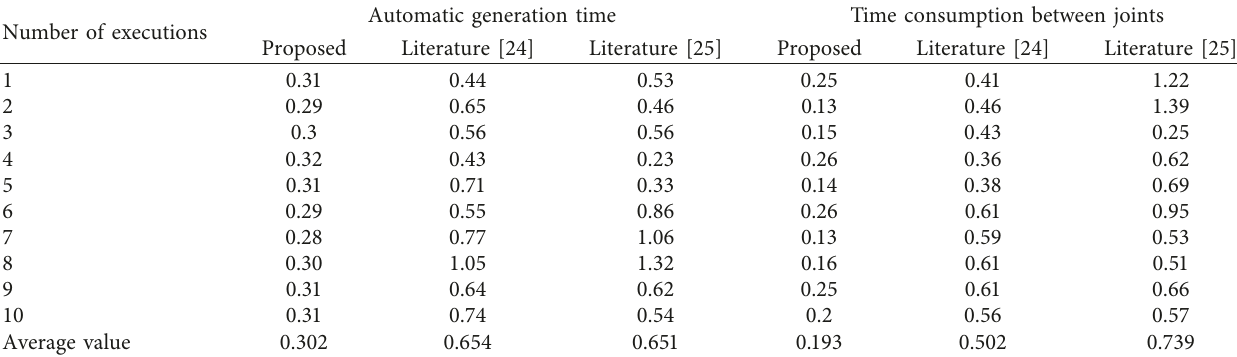
Table 2: Comparison of response time of fault-tolerant algorithms.